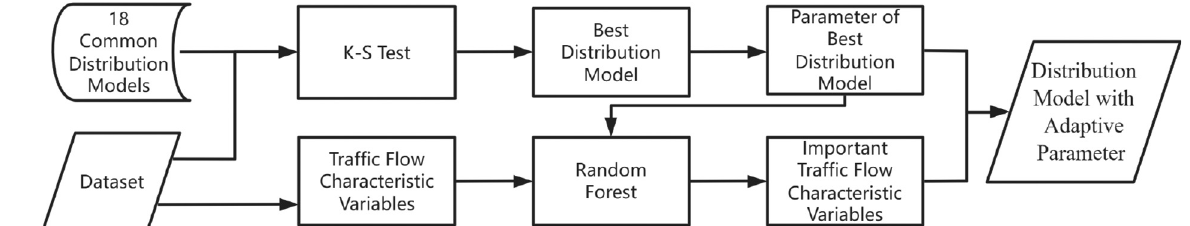
Figure 1 Work fl ow of THW adaptive parameter